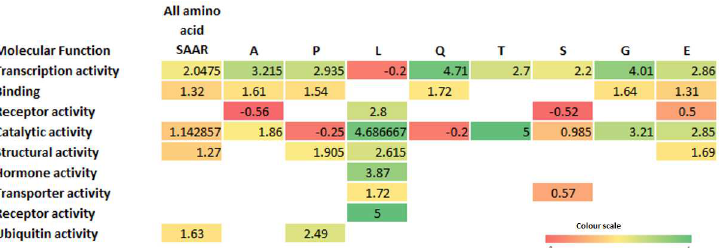
Fig 3. Distribution of various molecular activities associated with SAAR containing proteins in the human proteome. Molecularfunction class for proteins was annotated using the Panther database. Proteins with any amino acid repeat and proteinswith a particular abundantamino acid repeat such as proline,alanine, leucine,glutamine,threonine,serine, glycineand glutamic acid are reported. Each cell in the heat map shows the fold enrichmentbetweenexpectedand observed frequency in reference to the human proteome. The coloursin the heatmapscale from red to green where the fold enrichment is from 0 to 5 respectively.